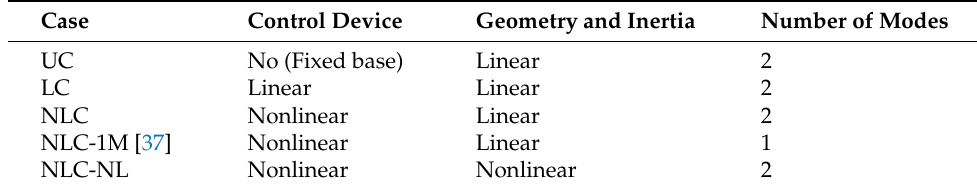
Table 2. Summary of the analyzed